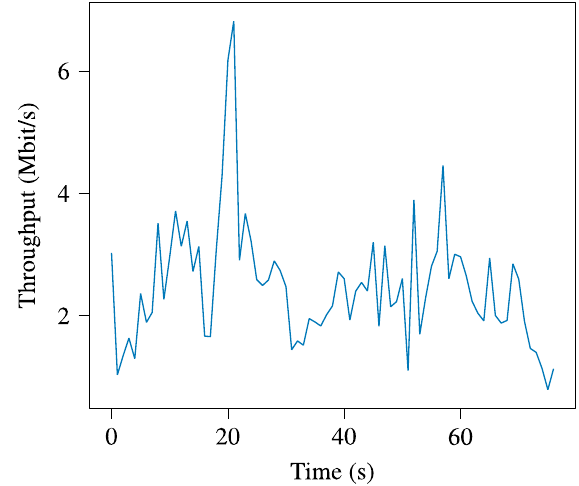
Figure 5. Service channel throughput during H9’s attack of H3.